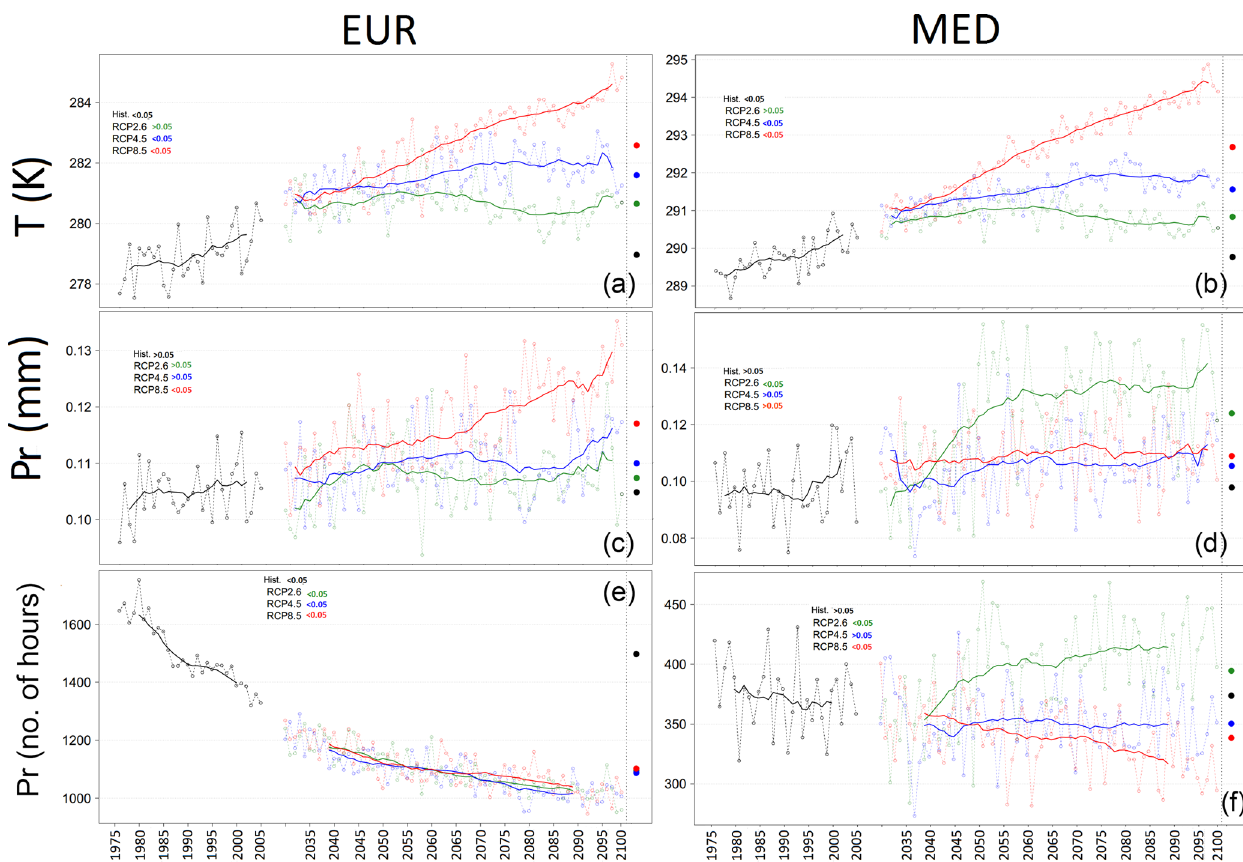
Figure 2. Time series of temperature (K; a , b ), precipitation (mm; c , d ) and number of rainy hours ( e , f ) for EUR ( a , c , e ) and MED ( b , d , f ) subdomains for all climate change scenarios as well as historic simulations. The average for each scenario is shown by the corresponding point on right side of the plot. The solid lines show the rolling average of 30 years for future scenarios and 20 years for historic scenarios. Numbers in the legend show the p value of the linear regression for each